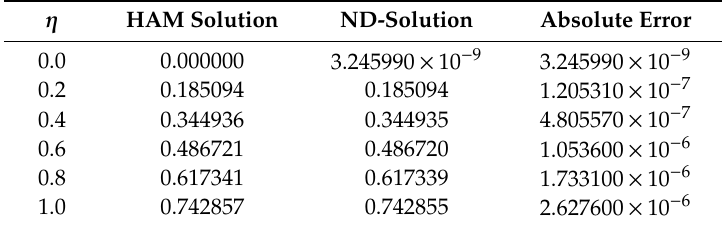
Table 1. The comparison of HAM and ND-Solve for di ff erent values of the dimensionless variable η .